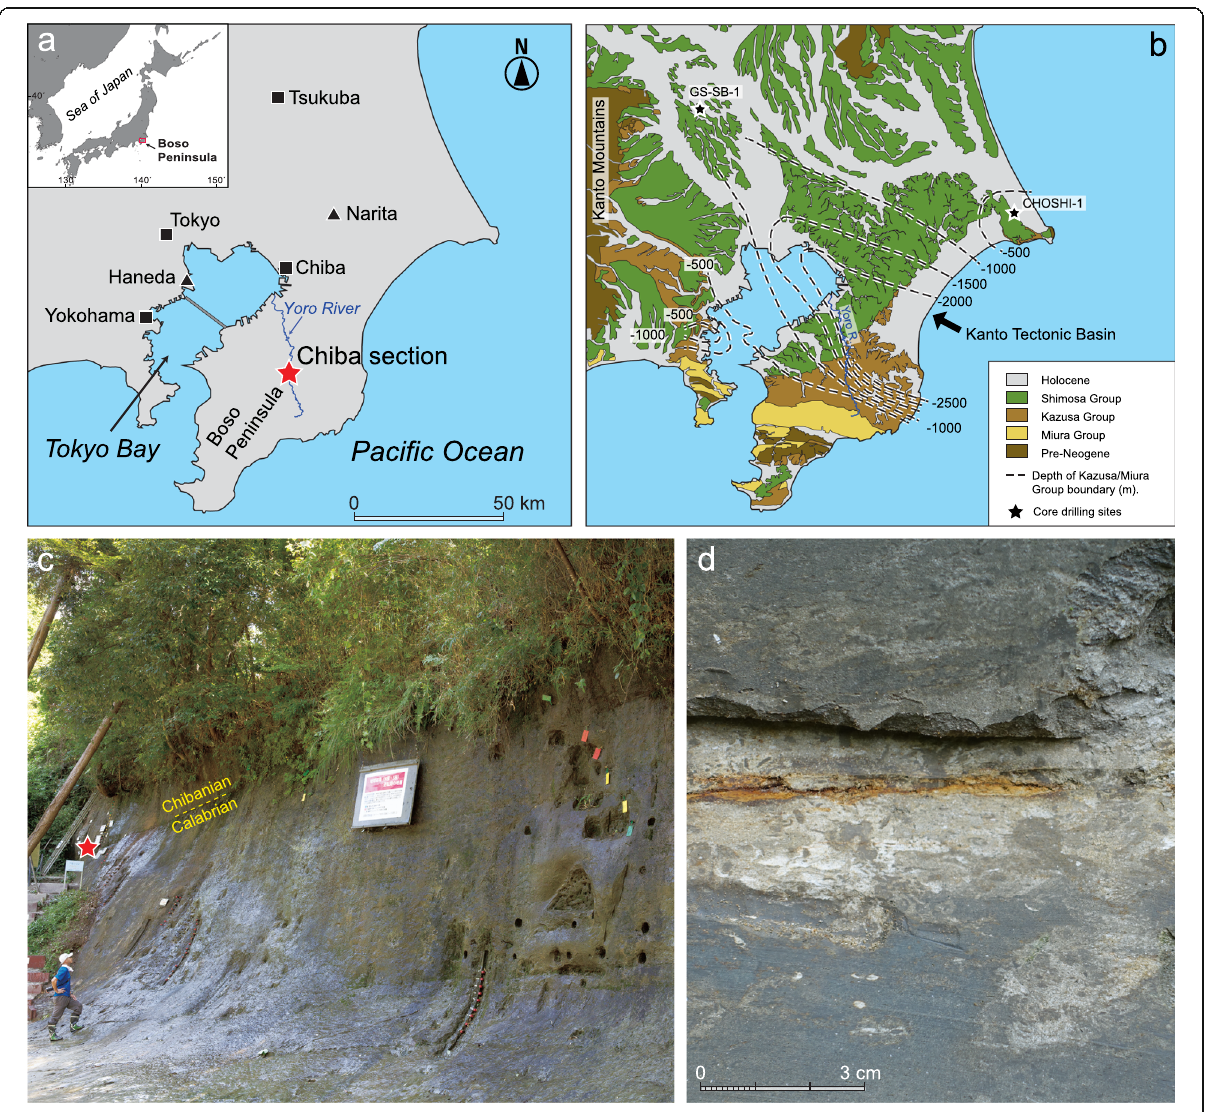
Fig. 14 The Chiba section, Japan. ( a ) Location of the Chiba section on the Boso Peninsula showing major cities. ( b ) Schematic geology of the Kanto area showing the depth (metres below sea level) of the base of the Kazusa Group (from fig. 1 of Kazaoka et al. 2015). ( c ) Chiba section showing faint but discernible parallel bedding in this massive siltstone unit; the location of the GSSP is indicated by a red star (from fig. 10 of Suganuma et al. in press). ( d ) Detail of the Ontake-Byakubi-E (Byk-E) tephra bed in the Chiba section at the position of the GSSP, showing bioturbation. The GSSP is located at the base of the tephra bed (photo by the author). The GSSP has an astronomical age of 774.1 ± 5 ka and is 1.1 m below the directional midpoint of the Matuyama – Brunhes paleomagnetic reversal (Suganuma et al. in